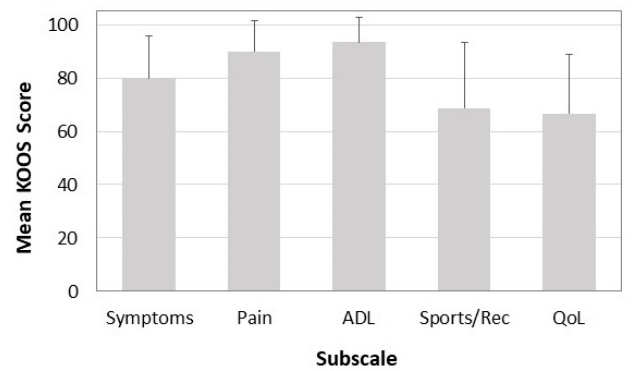
Figure 3. Knee Injury and Osteoarthritis Outcome Scores (KOOS) for ChondroMimetic subjects at a mean follow-up of 7.9 years. Data represents mean + standard deviation (n = 15).